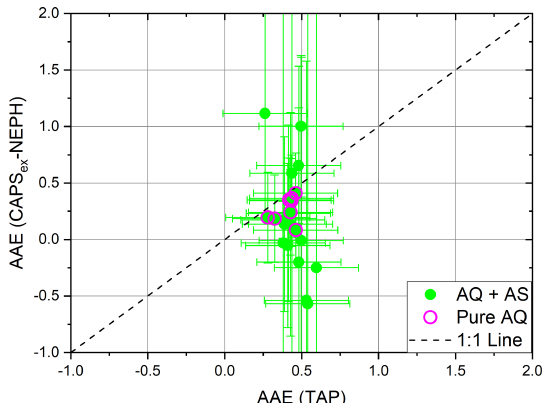
Figure 13. Scatter plot of AAE(CAPS, NEPH) measurements com- pared to AAE(TAP) measurements for pure AQ and AQ–AS exter- nal mixtures. Measured precision error bars are shown for individ- ual externally mixed AQ–AS measurements.